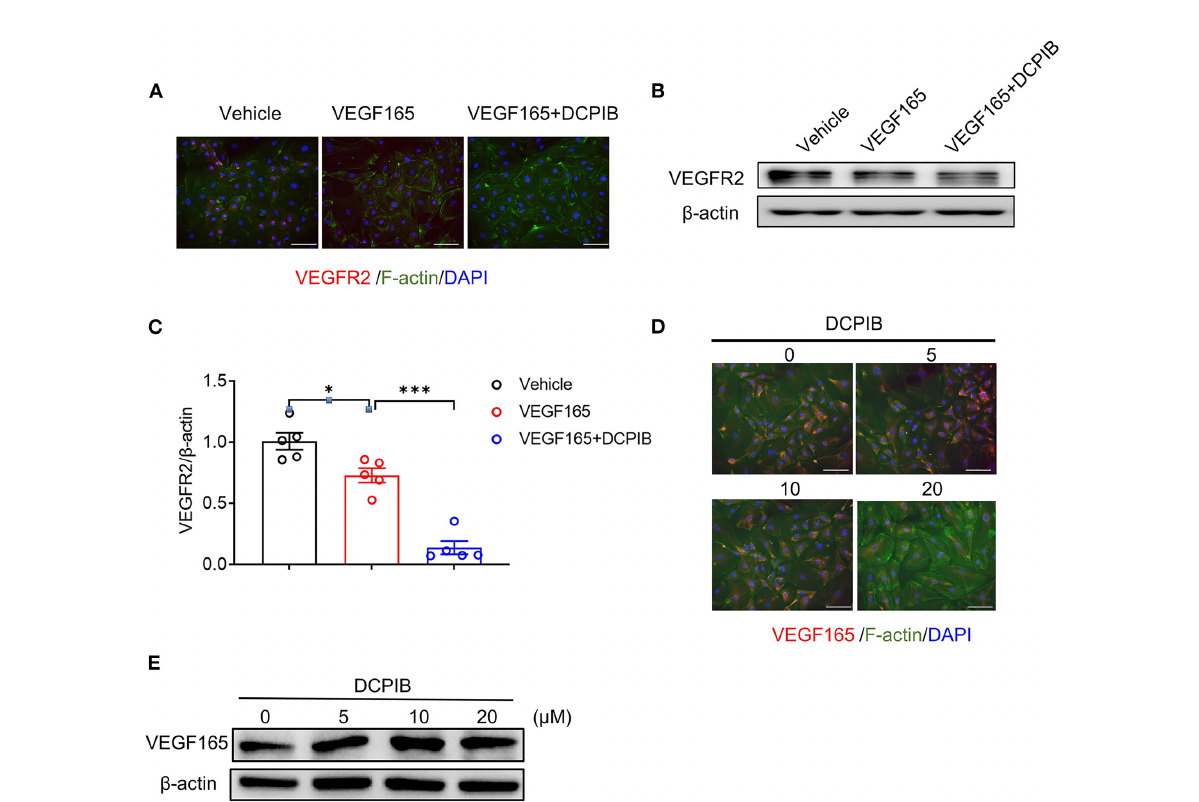
FIGURE5 DCPIB reduced VEGFR2 expression. (A) Representative images of Immunofluorescence of VEGFR2 expression in HUVECs treated with vehicle, VEGF165 and DCPIB for 48h ( n = 3). VEGFR2 (red), DAPI (blue) and F-actin (green). Scale bar = 50 µ m. (B,C) Representative western blot and quantitative analysis of the VEGFR2 protein expression in HUVECs treated with vehicle, VEGF165 and DCPIB for 48h ( n = 5). (D) Immunofluorescence detection of VEGF165 expression in HUVECs treated with DCPIB (0, 5, 10, 20 µ M). VEGFR2 (red), DAPI (blue) and F-actin (green). Scale bar = 50 µ m. (E) Western blot analysis of VEGF165 expression in HUVECs treated with DCPIB (0, 5, 10, 20 µ M). * p < 0.05, *** p <